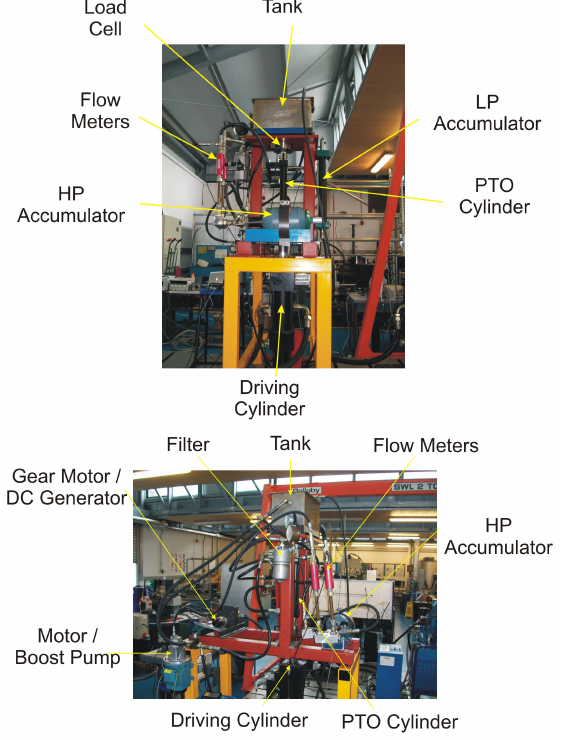
Figure 9. Front and side view of constant pressure test